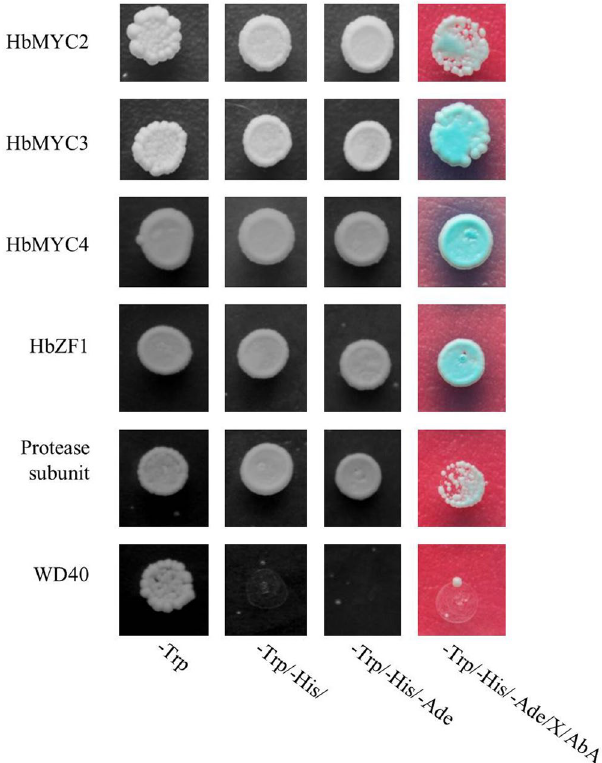
Figure 1. Autoactivation and toxicity test of HbJAZ-interacting proteins. The full-length Hevea HbMYC2 , HbMYC3 , zinc-finger , protease subunit , and WD40 genes were cloned into a pGBKT7 vector to generate bait plasmids, which were subsequently transformed into Y2HGold strains and plated onto plates containing the following media: SD/-Trp, SD/-Trp/-His/, SD/-Trp/-His/-Ade, or SD/-Trp/-His/-Ade/X- α -gal/AbA (125